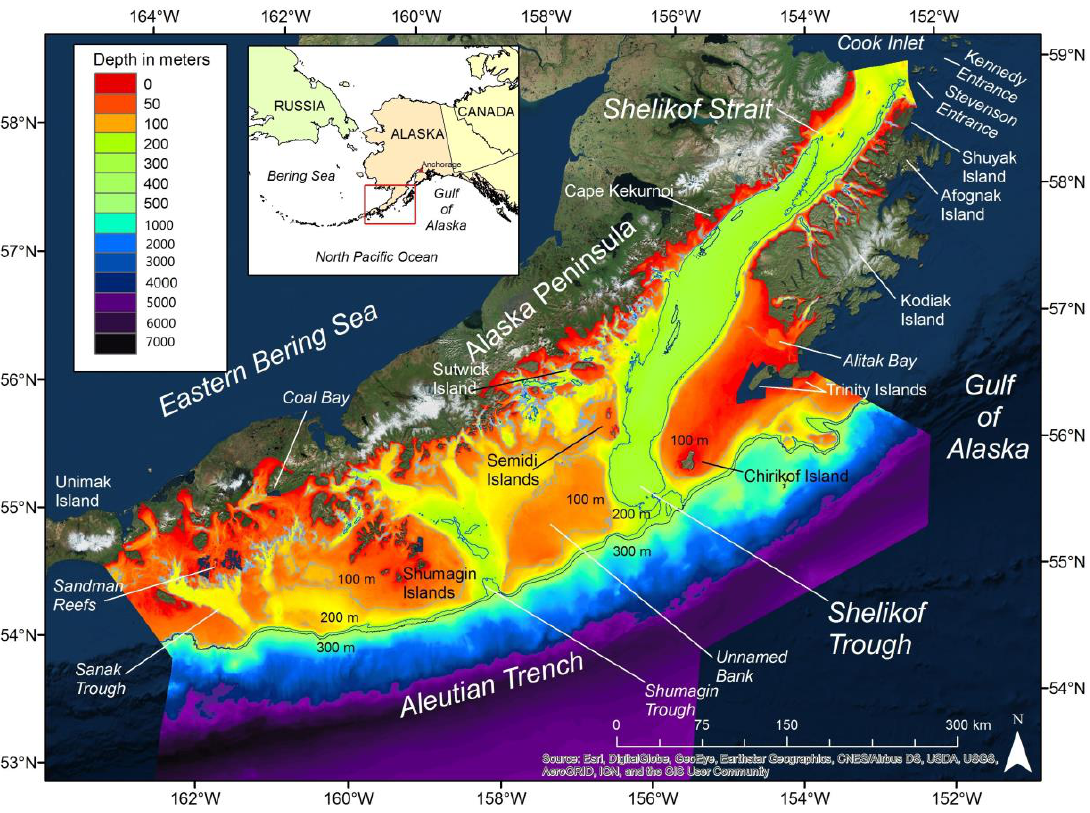
Figure 3. Bathymetry of the western Gulf of Alaska.